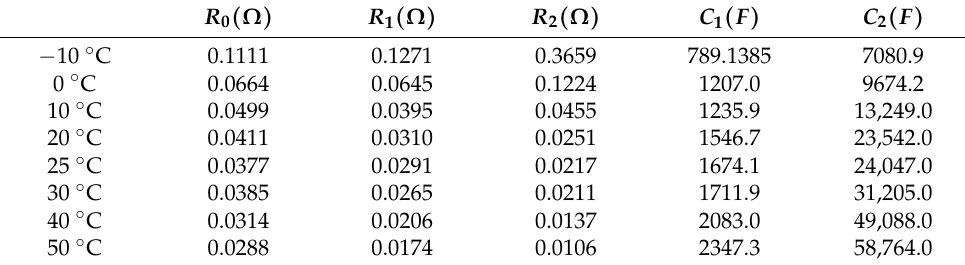
Table 1. Parameter identification results of the FFLS method.